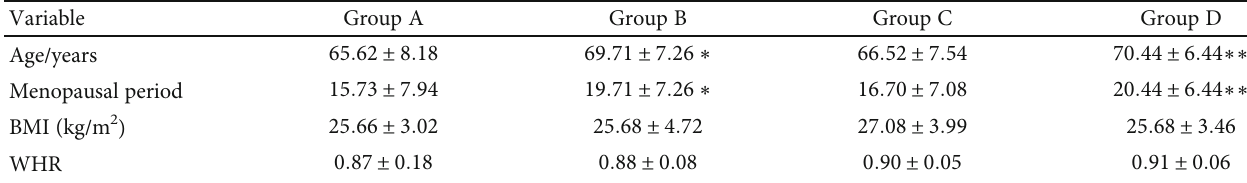
Table 1: Comparison of baseline data among groups ( − x ± s